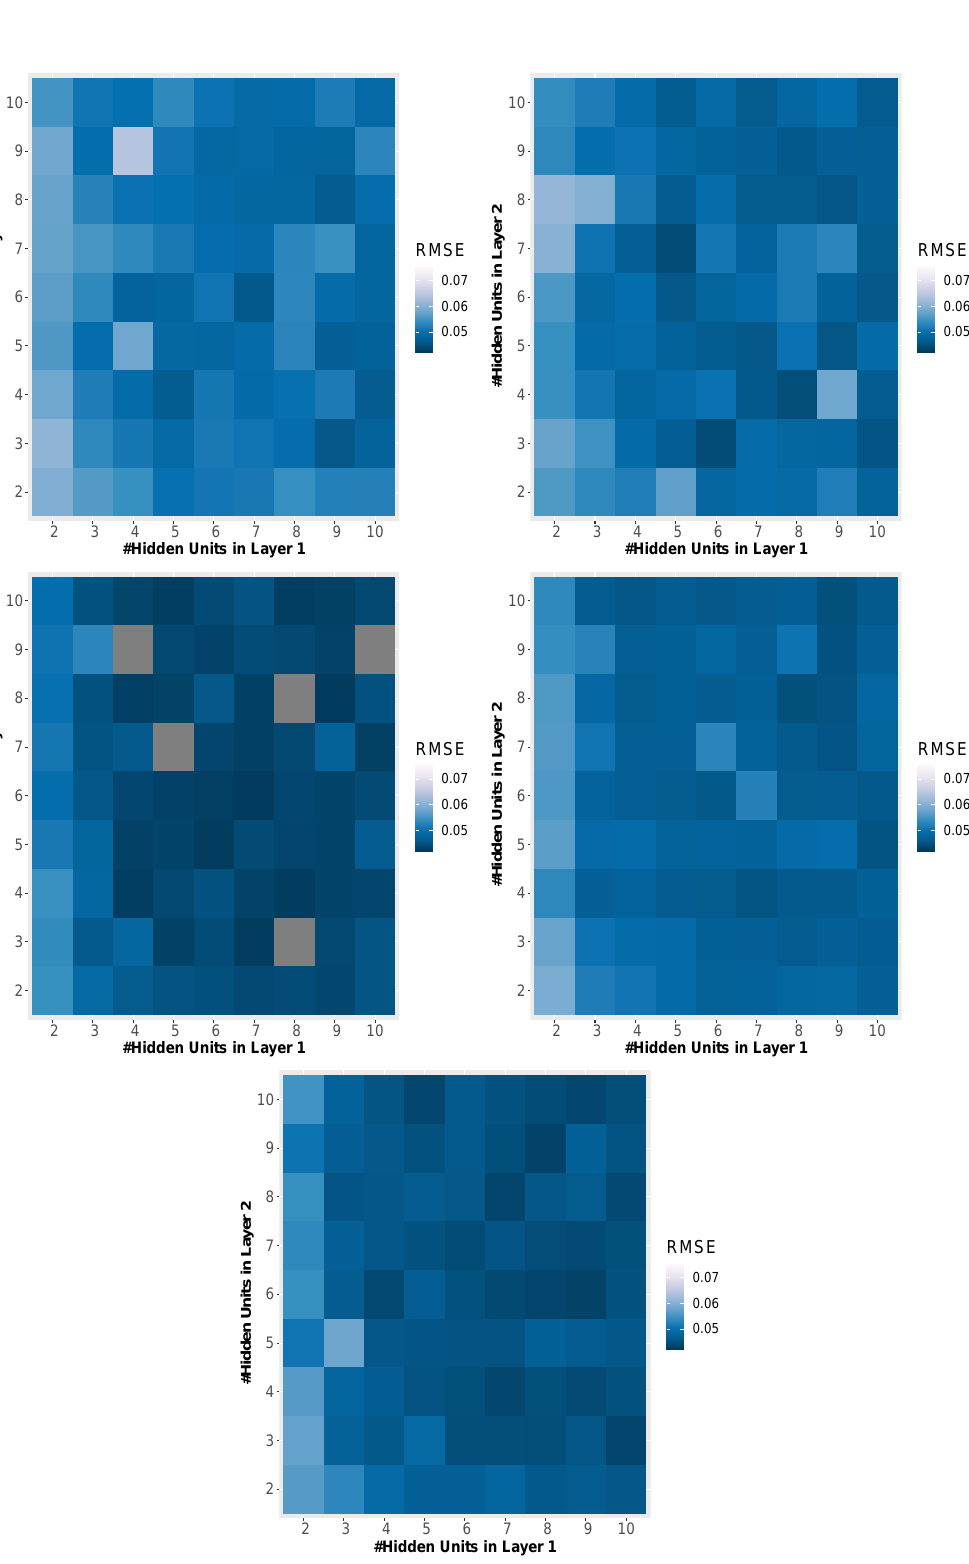
Figure 4. RMSE matrix for different number of neurons in the hidden layers. From top to bottom and left to right, the number of input data goes from 7 to 3. The x axis represents the number of neurons in the first hidden layer and the y axis is the number of neurons in the second hidden